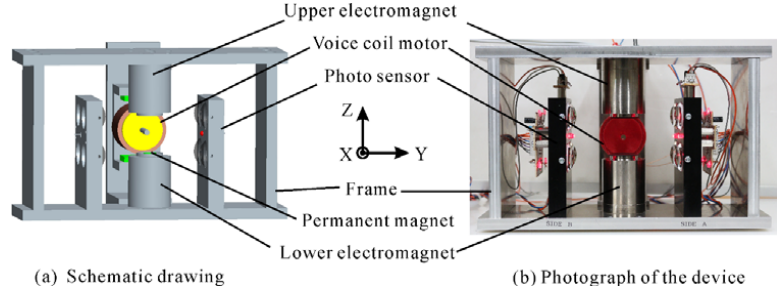
Figure 5. Developed three ‐ degree ‐ of ‐ freedom experimental system: ( a ) schematic drawing; ( b ) photograph of the device.